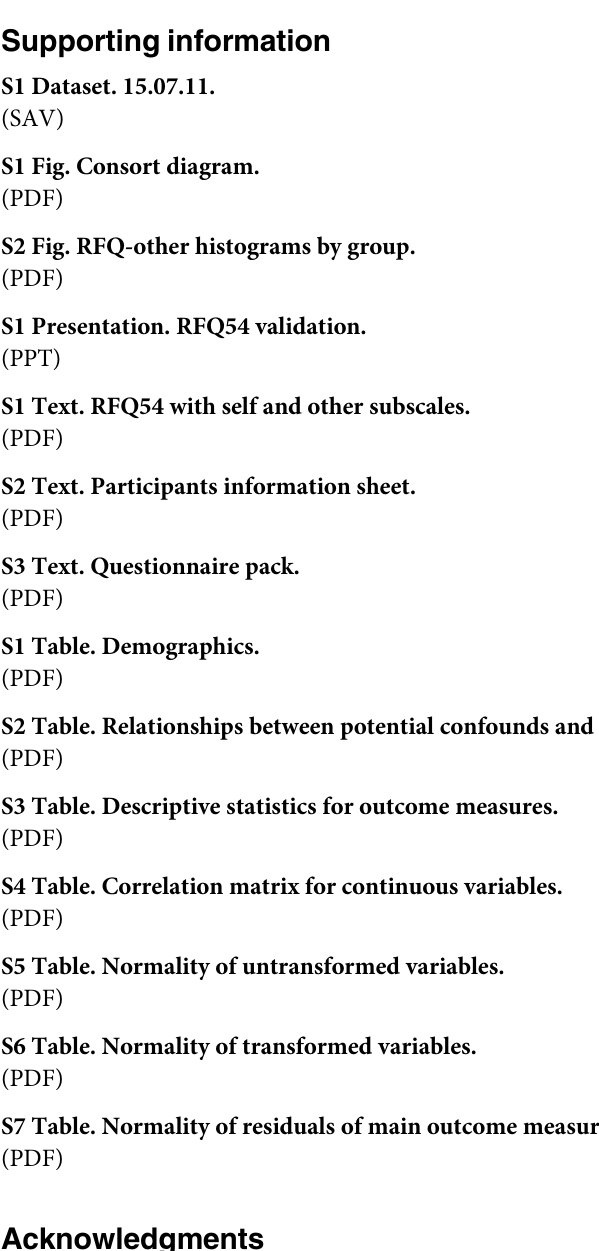
S5 Table. Normality of untransformed variables. S6 Table. Normality of transformed variables. S7 Table. Normality of residuals of main outcome